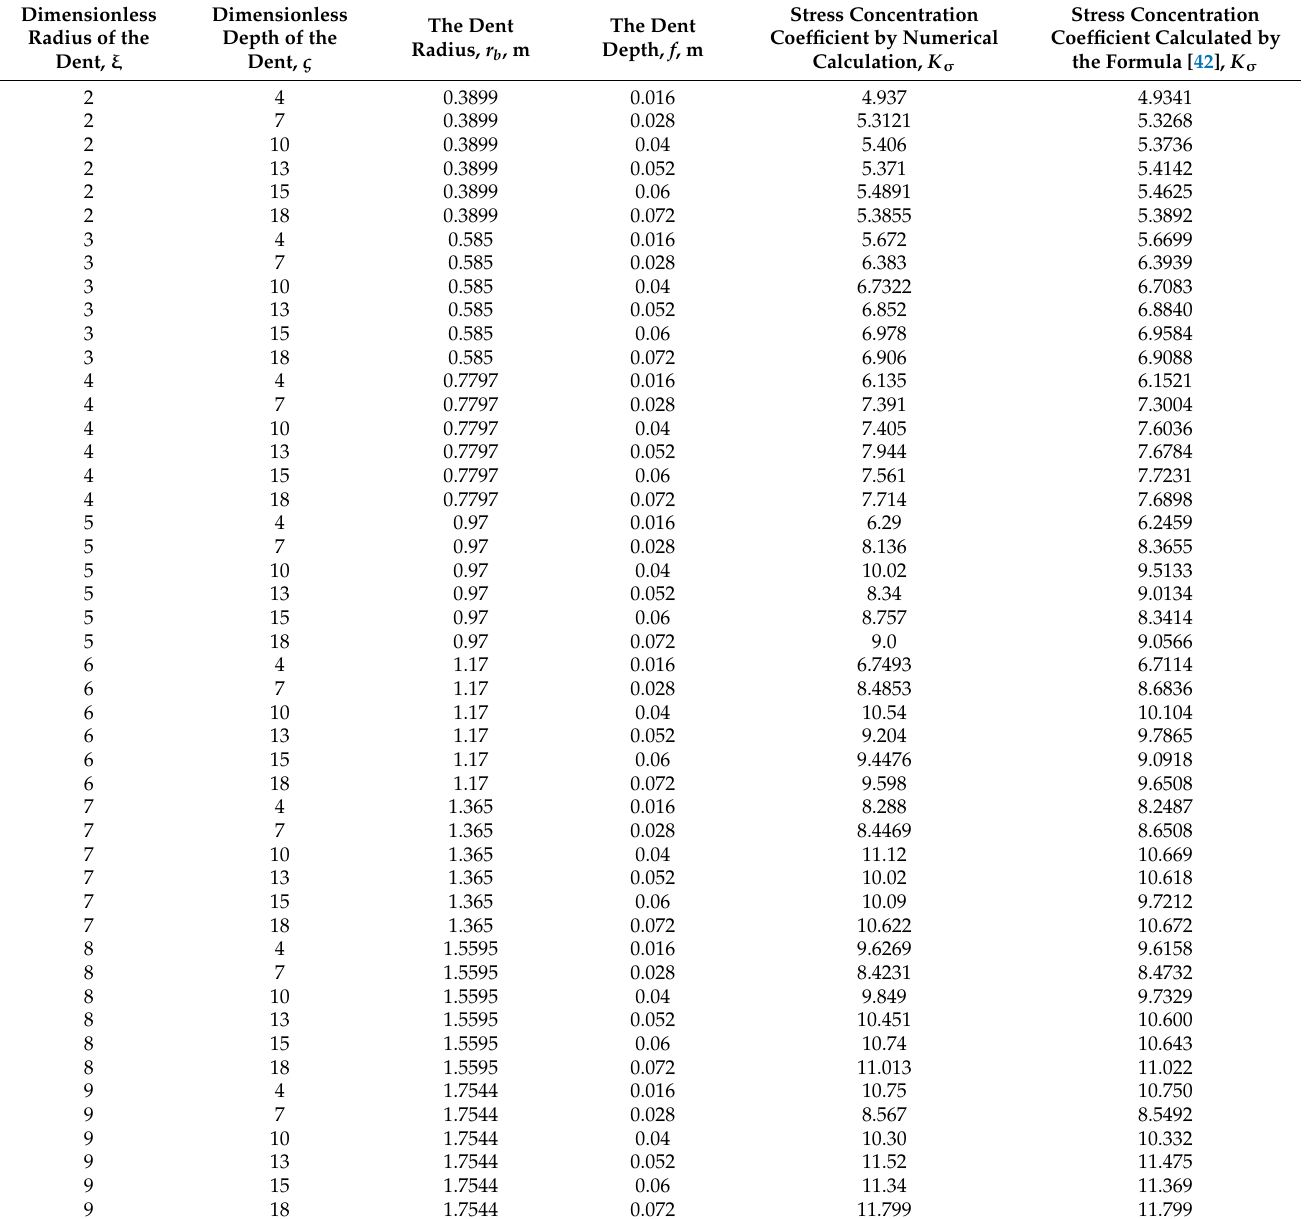
Table 6. The results of comparing the values of stress concentration coefficients calculated by the numerical method and using the